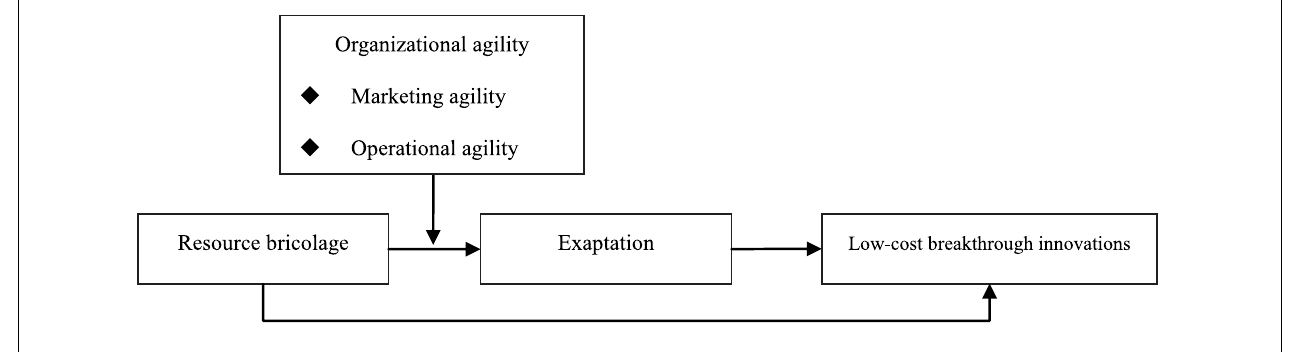
FIGURE 1 | Theoretical